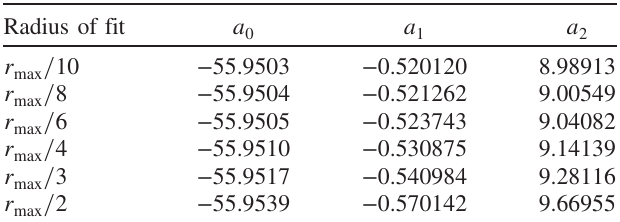
TABLE I. Parameters for a fit of an Enge function of the form (63), to the quadrupole gradient in an HL-LHC inner triplet quadrupole. The maximum radius r in the field data is 75 max